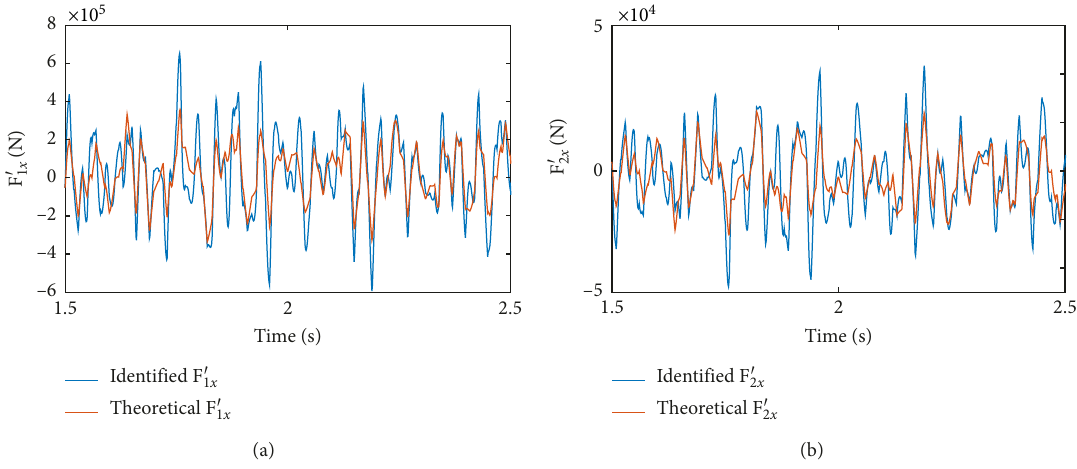
Figure 11: Equivalent forces F